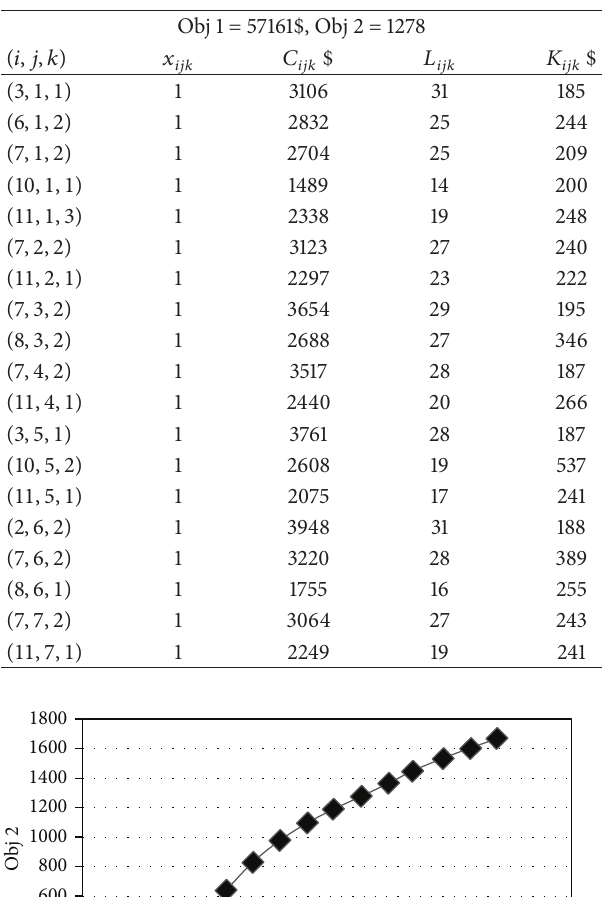
Table 4: Output results.